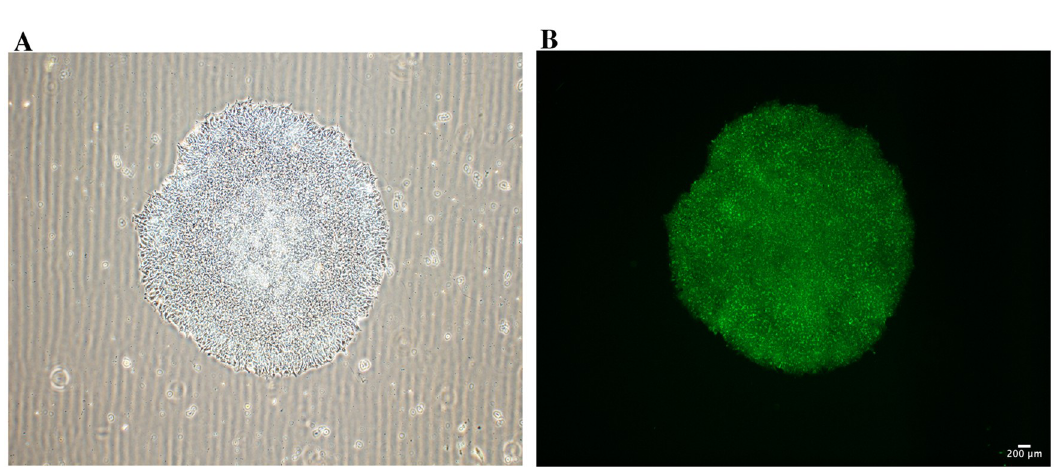
Fig 2. (A) Morphology of a centenarian-derived iPSC colony. Typical pluripotent stem cell colony features including round shape, sharp edges and dense, homogenous cells are shown. (B) Alkaline Phosphatase Activity staining performed on a representative centenarian iPSC